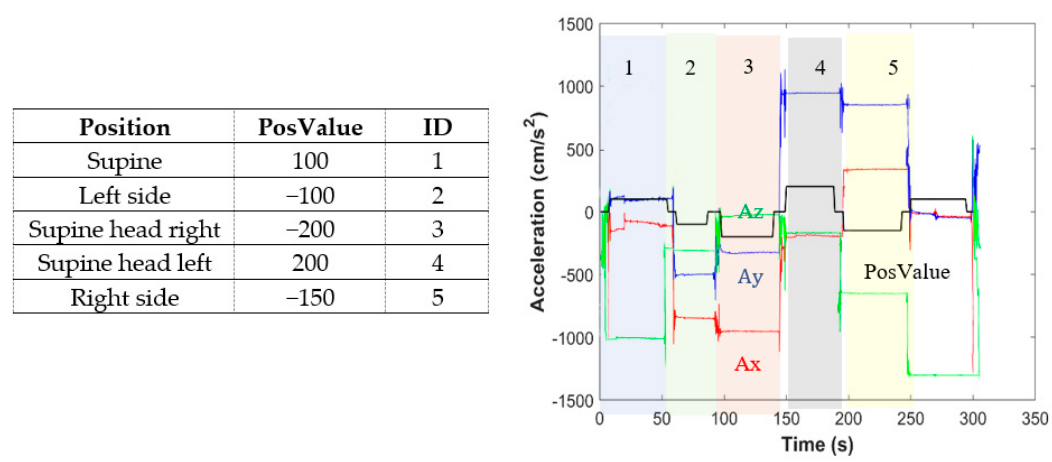
Figure 21. PosValues overlapped on the three raw acceleration signals and. Right: PosValues according to position.